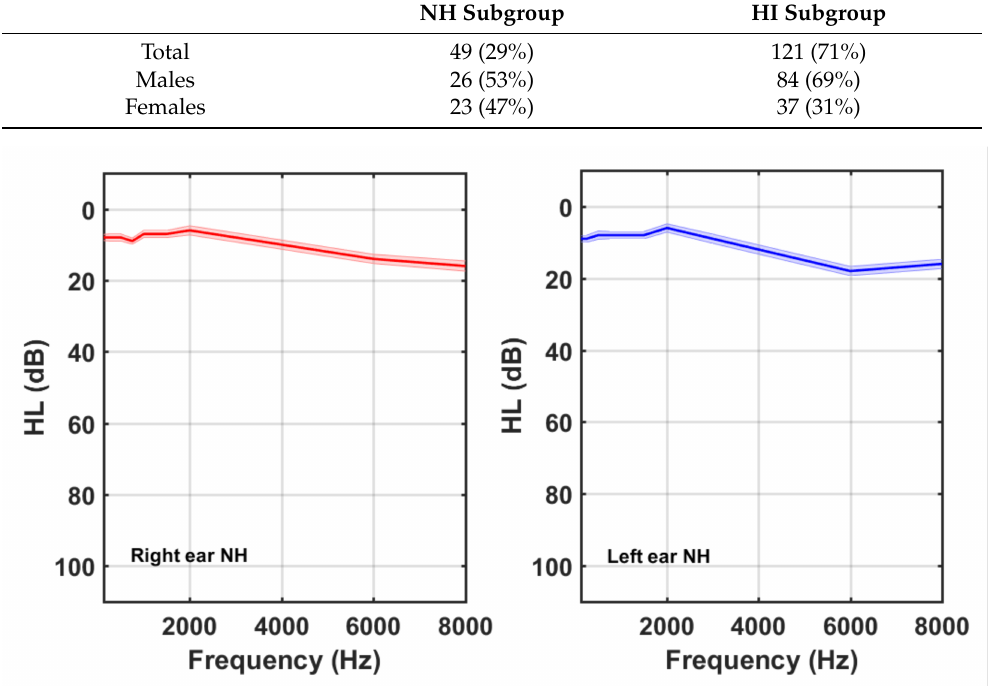
Figure 2. Right and left ear averaged HL curves for tinnitus participants of the NH